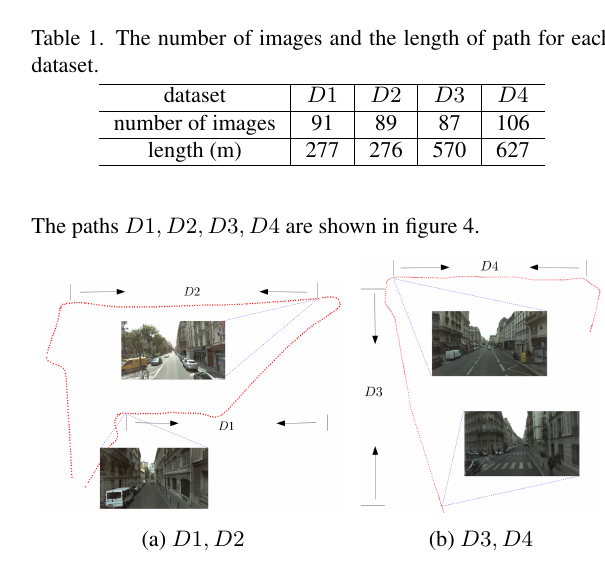
Figure 4. The red dots are the locations of images and the images show the first view of the sequence.